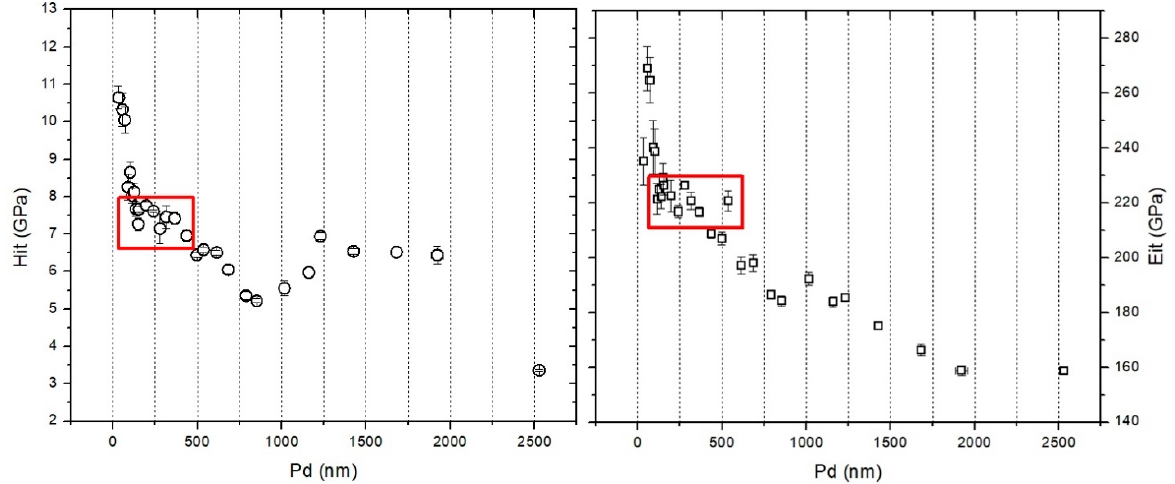
Figure 10. The variation of the hardness and elastic modulus as a function of the penetration depth.